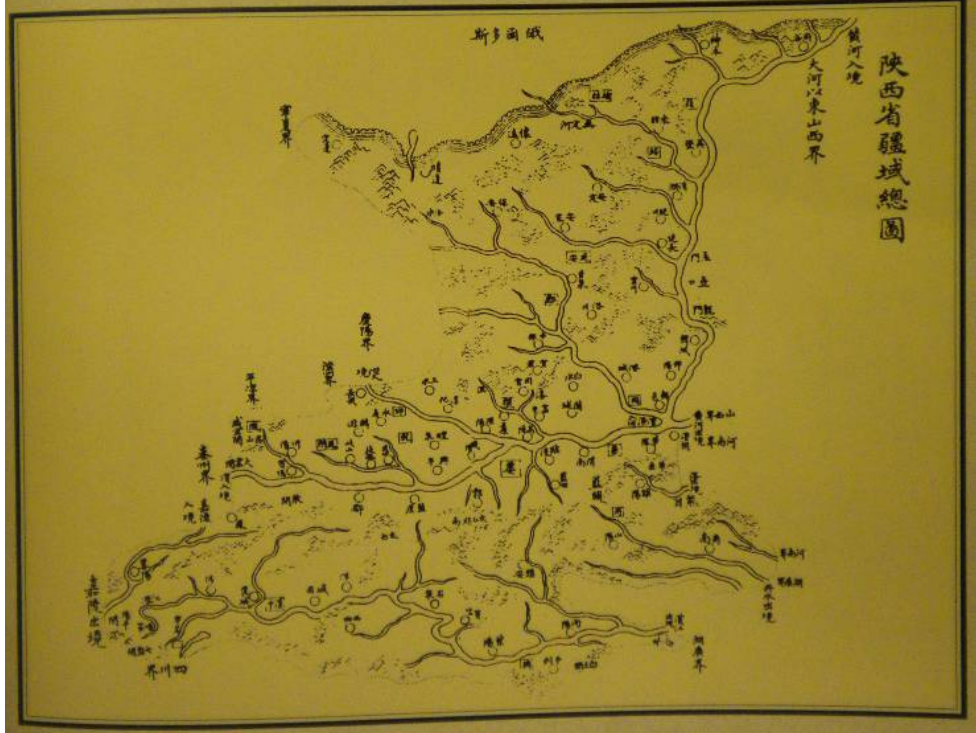
Figure 1. Map of Shaanxi province in 1735. Source: Shaanxi Tong Zhi [ 陕西通志 ] (1735) [20].